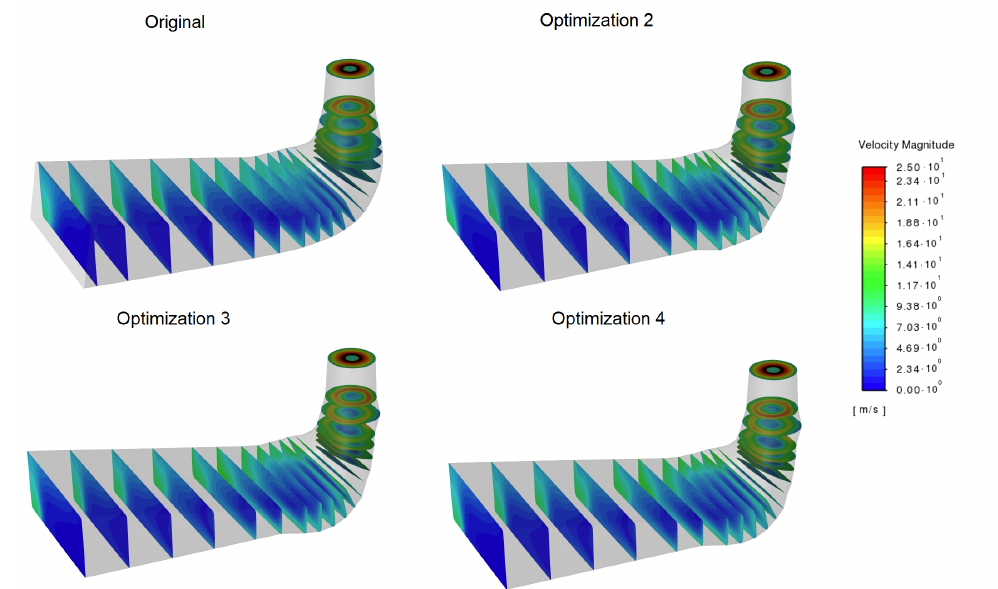
Figure A6. Velocity magnitudes in several draft tube cross-sections for a 12.8 m 3 /s flow rate.